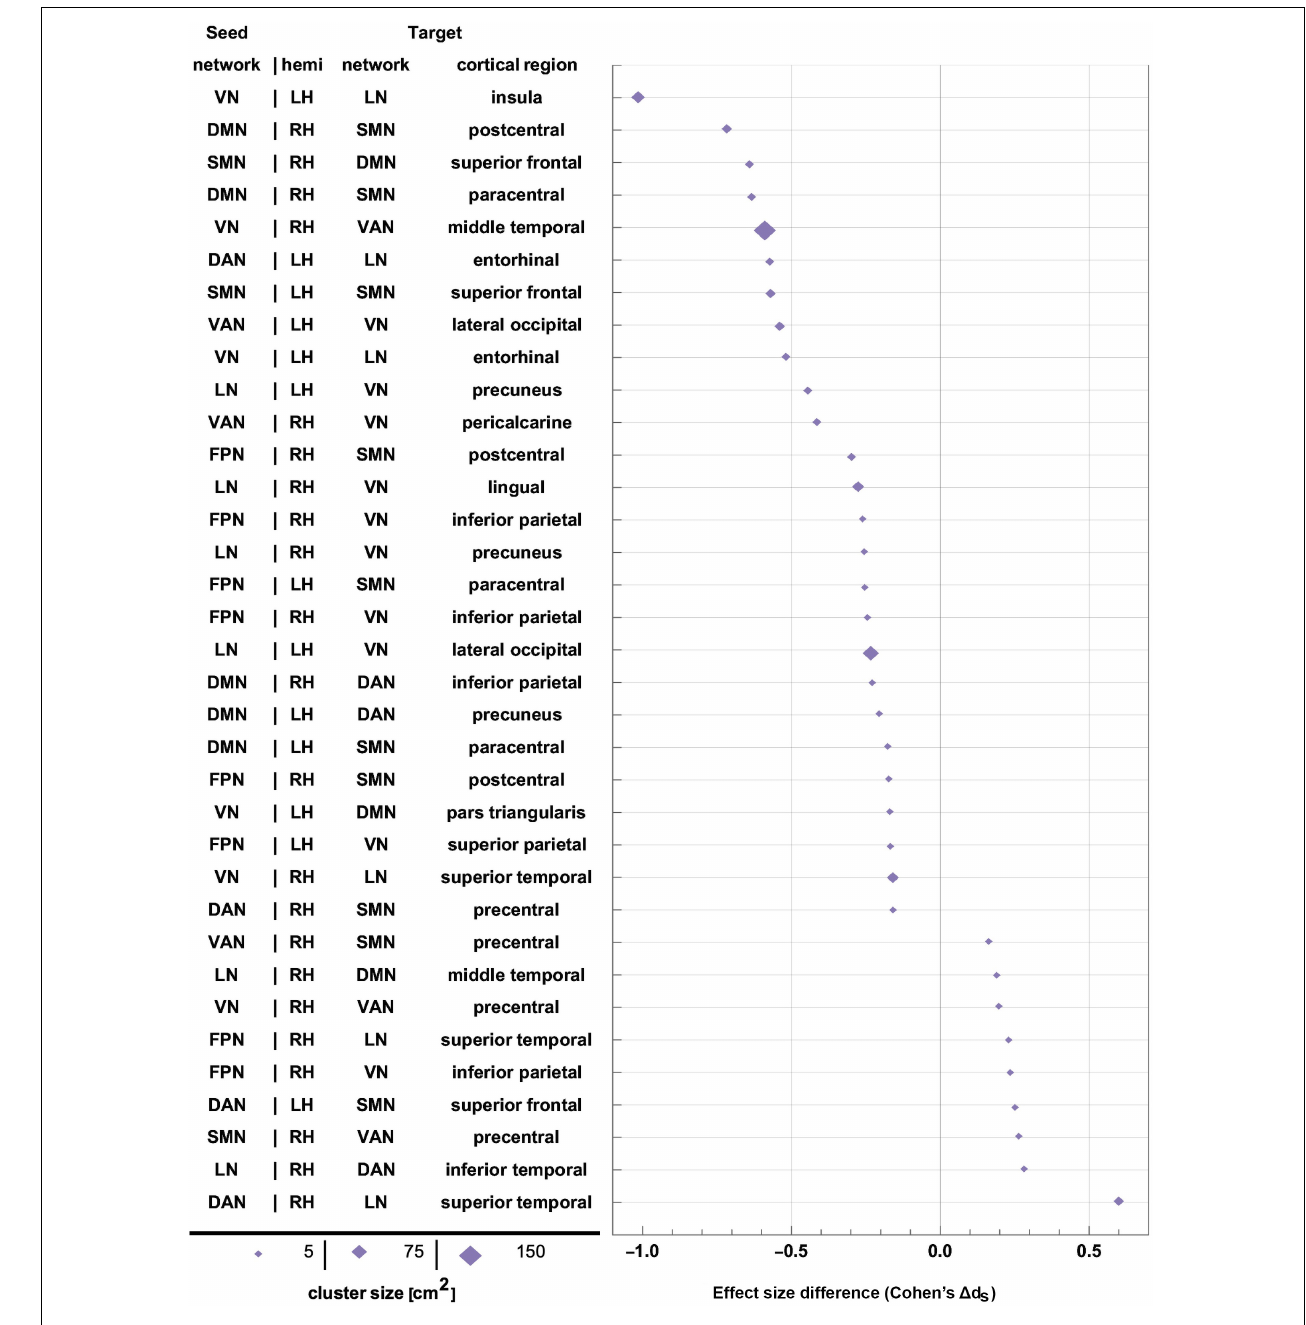
FIGURE 9 | Effect sizes of FC changes predicated significantly upon sex. Pairs of RSNs (seeds) and corresponding statistically significant clusters (targets) are listed according to sex differences in effect size (Cohen’s d S = d M − d F , where d M and d F are Cohen’s d values for males and females, respectively). Values of d S are plotted on the horizontal axis, sorted in ascending order. Marker size is proportional to cortical cluster size. FC, functional correlation; RSN, resting state